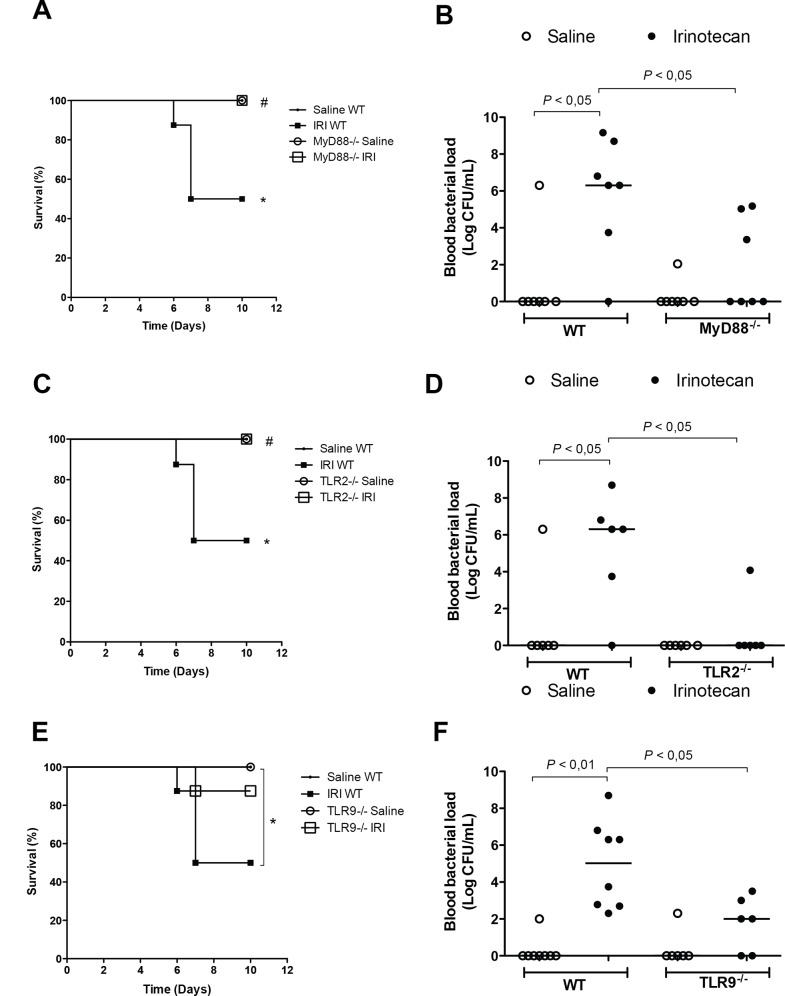
Irinotecan reduces animal survival and increases bacteremia, which were prevented in the MyD88-/- and TLR2-/- mice.The mice (n = 6–9) were injected for 4 days with saline (3 mL/kg) or irinotecan (75 mg/kg, i.p.) and survival was monitored during the whole experimental period. A blood sample was collected on day 7 to measure the bacterial load. The WT mice that were injected with irinotecan showed a significantly reduced survival (A, C and E) and increased bacteremia (B, D and F) versus the saline-injected group. MyD88- and TLR2-, but not TLR9-, knockout mice showed an improved survival (A, C and E, respectively). The blood bacterial load was reduced in all knockout mice (B, D and F). *P<0.05 vs the WT saline group; #
P <0.05 knockout groups vs the WT group injected with irinotecan.